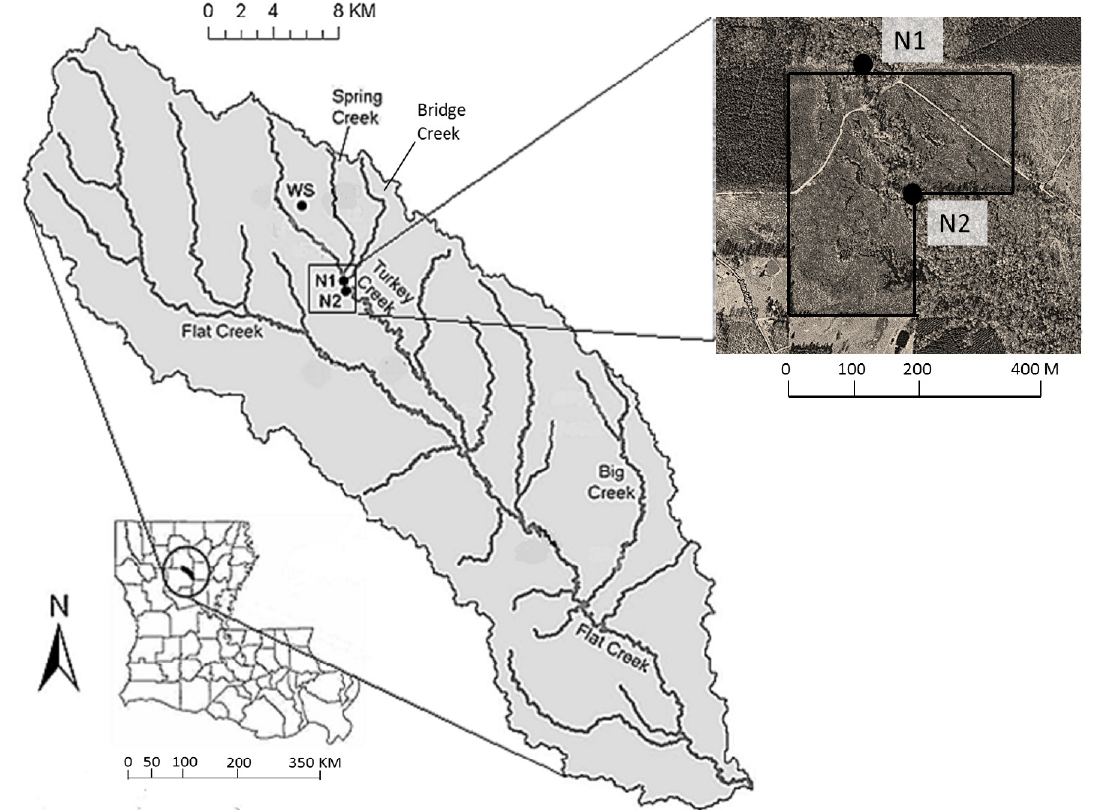
Figure 1. Geographical location of the Flat Creek watershed in Winn Parish, Louisiana, USA, and the study sites (labeled N1 and N2). A closer image of N1 and N2 is also shown (taken from Google Map), with the sites above (N1) and below (N2) the harvested pine stand (outlined in black). Also pictured is the weather station